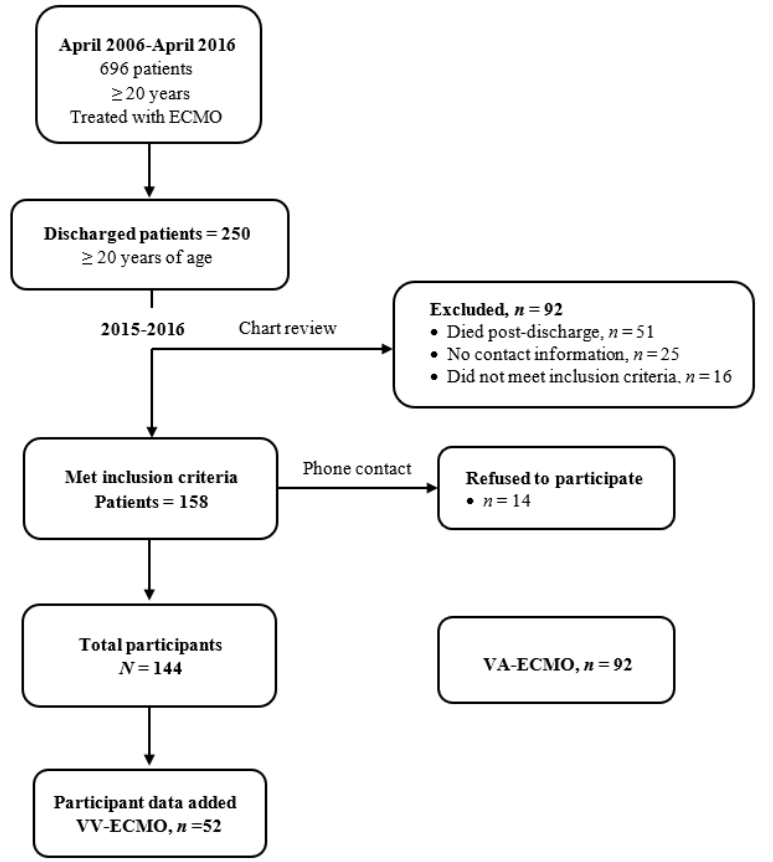
Figure 2. Flow chart of participant selection for data collected for VV-ECMO patients in 2015–2016.